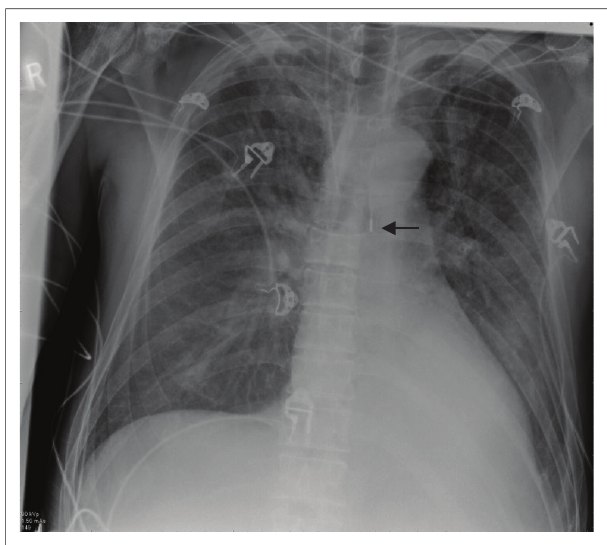
FIGURE 1: Chest radiograph showing an intra-aortic balloon pump placed in a 53-year-old male with acute post-infarction ventricular septal rupture and cardiogenic shock. Note that the radiopaque tip of the intra-aortic balloon pump (arrow) is at or below the level of the carina and needs to be advanced by 2